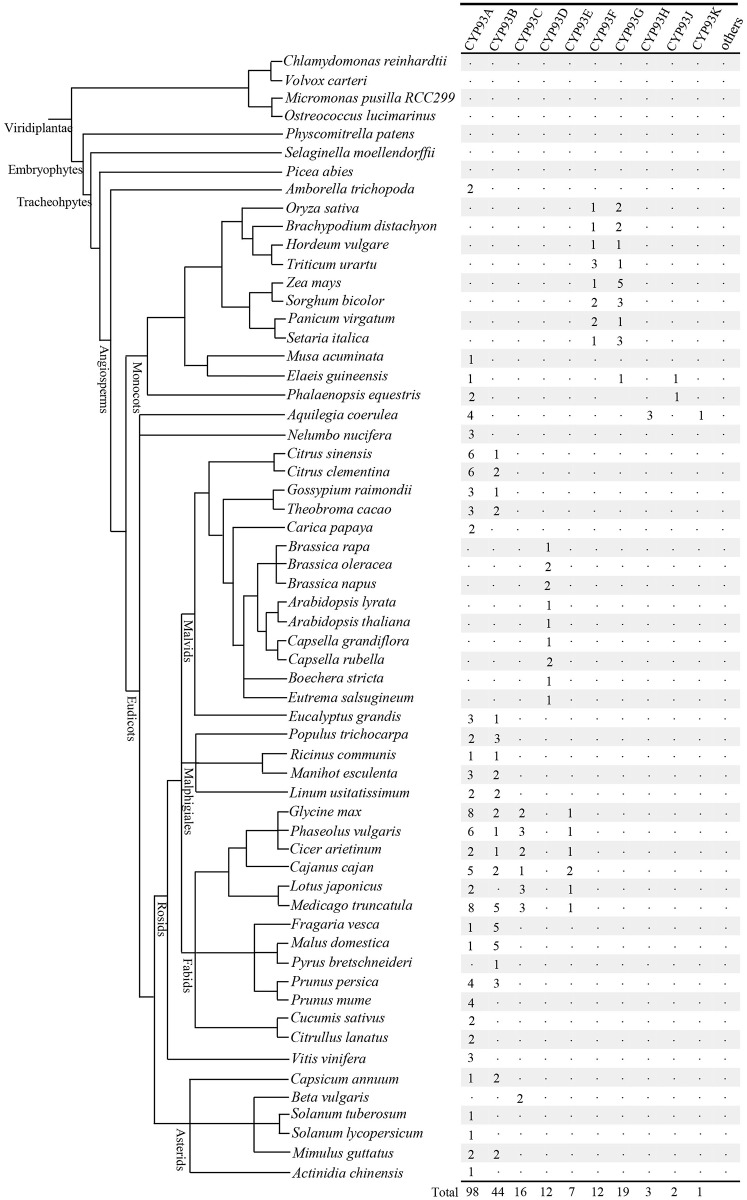
Phylogenetic relationships of the 60 species investigated in the present study.Phylogenetic relationships (branch lengths are arbitrary) among these species have been described previously (http://www.phytozome.net/). The total number of cytochrome P450 93 (CYP93) proteins identified in each genome is indicated on the right.